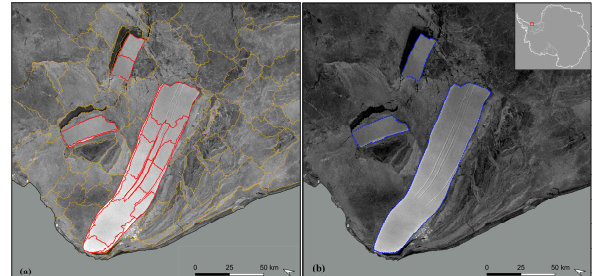
Figure 5. Fracture features in Landsat and Radarsat-1 images of